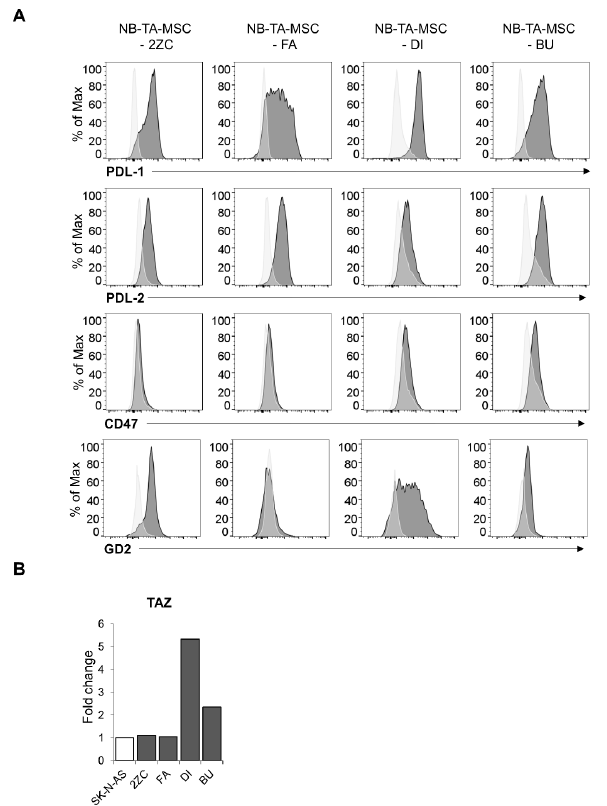
Figure 1. Evaluation of the expression of immunomodulatory molecules in primary NB-TA-MSC cultures. ( A ) Flow cytometry analysis of the indicated surface markers (PD-L1, PD-L2, CD47 and GD2) in primary NB-TA-MSC cultures. Light grey histograms represent unstained control; dark grey histograms represent stained samples. A representative experiment is shown of n = 5 experi- ments performed. ( B ) RT-qPCR analysis of TAZ transcript in different primary NB-TA-MSC cul- tures. The NB commercial cell line SK-N-AS was used as a reference control since these cells display a mesenchymal phenotype and high TAZ expression [27]. Histograms represent the fold change of gene transcript expression normalized for GAPDH expression compared to SK-N-AS expression, whose level is arbitrarily set as 1. Data are expressed as mean ± SD ( n = 3). Replicative senescence (growth-arrest) of normal MSC is characterized by some func- tional defects [20,24,32,33], and senescent cells are identified for the SA- β -gal staining. Analysis of Figure 2A shows that young proliferating NB-TA-MSC are negative for the SA- β -gal staining, while a prolonged culture of 2ZC primary cell culture produced non- proliferating culture with ≥95% of cells positive for the SA- β -gal staining (Figure 2B), in- dicating that almost all of these cells become senescent at high-passage. We also received